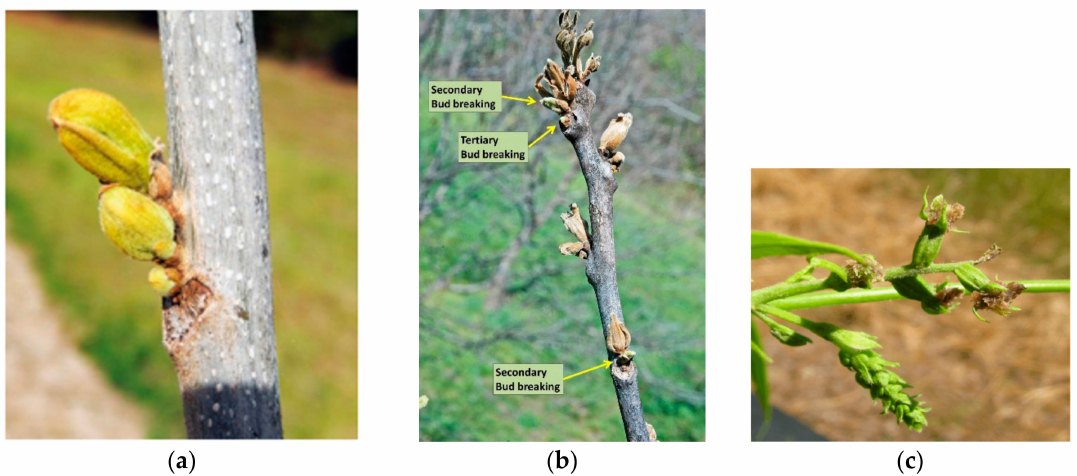
Figure 1. ( a ) Multiple buds at a node [38]. ( b ) Dead terminal buds after 15 April 2014 freeze